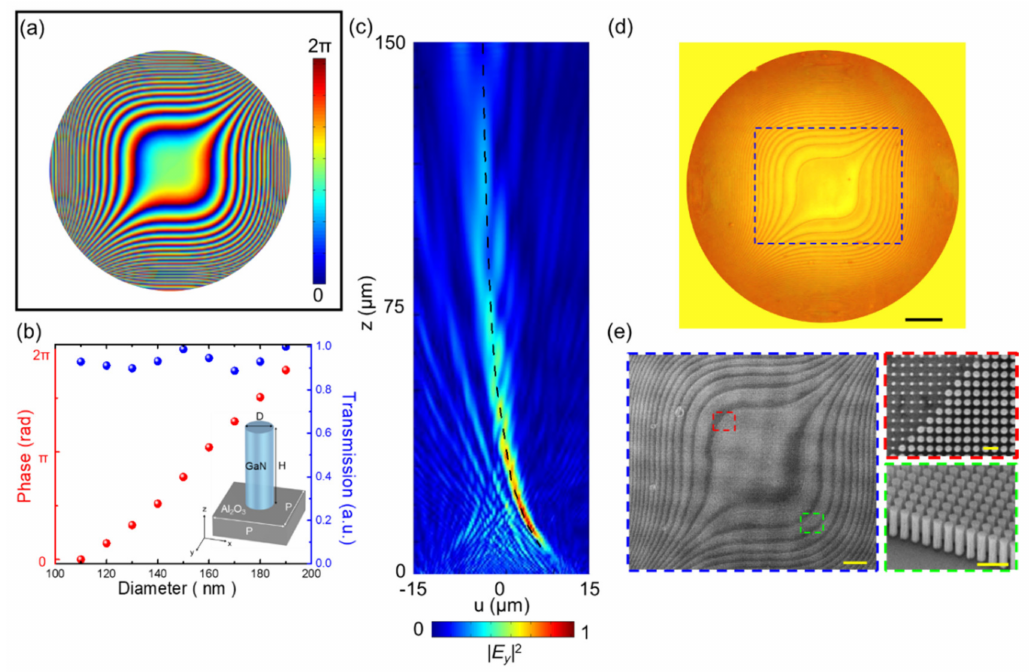
Figure 2. Design, simulation, and fabrication of a vertically accelerated 2D Airy beam generated by a cubic-phase metasurface. ( a ) Phase distribution of the cubic-phase metasurface. ( b ) The cubic-phase metasurface is composed of GaN circular nanopillars with a height of 800 nm and a pitch (P) of 250 nm on an Al 2 O 3 substrate. The corresponding phase delay level and transmission of GaN circular nanopillars are 110 nm to 190 nm diameter (D). ( c ) FDTD simulated the intensity distribution profile of the GaN metasurface with a cubic phase along the optical axis at the operating wavelength of 532 nm under y-polarized incident light. The black dash line shows the theoretical propagation trajectory of the cubic-phase metasurface. ( d ) Photographic image of the fabricated cubic-phase metasurface. Scale bar: 50 µ m. The blue dashed square denotes the region of the SEM image shown in ( e ). ( e ) SEM image of the center position of the fabricated metasurface. Scale bar: 20 µ m. Top (highlighted in a red square) and tiled views (highlighted in a green square) of a zoomed-in SEM image of GaN circular nanopillars. Scale bar: 0.5 µ